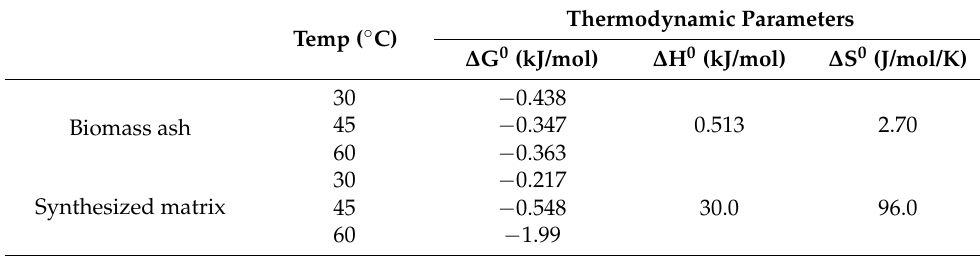
Table 3. Thermodynamic parameters of biomass ash and the synthesized